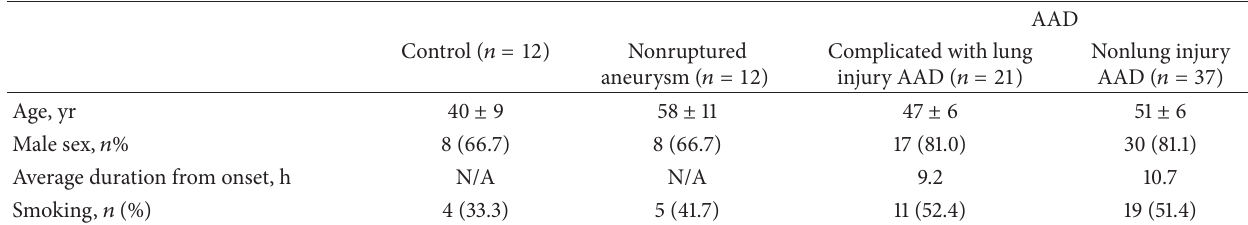
Table 1: Clinical features of the